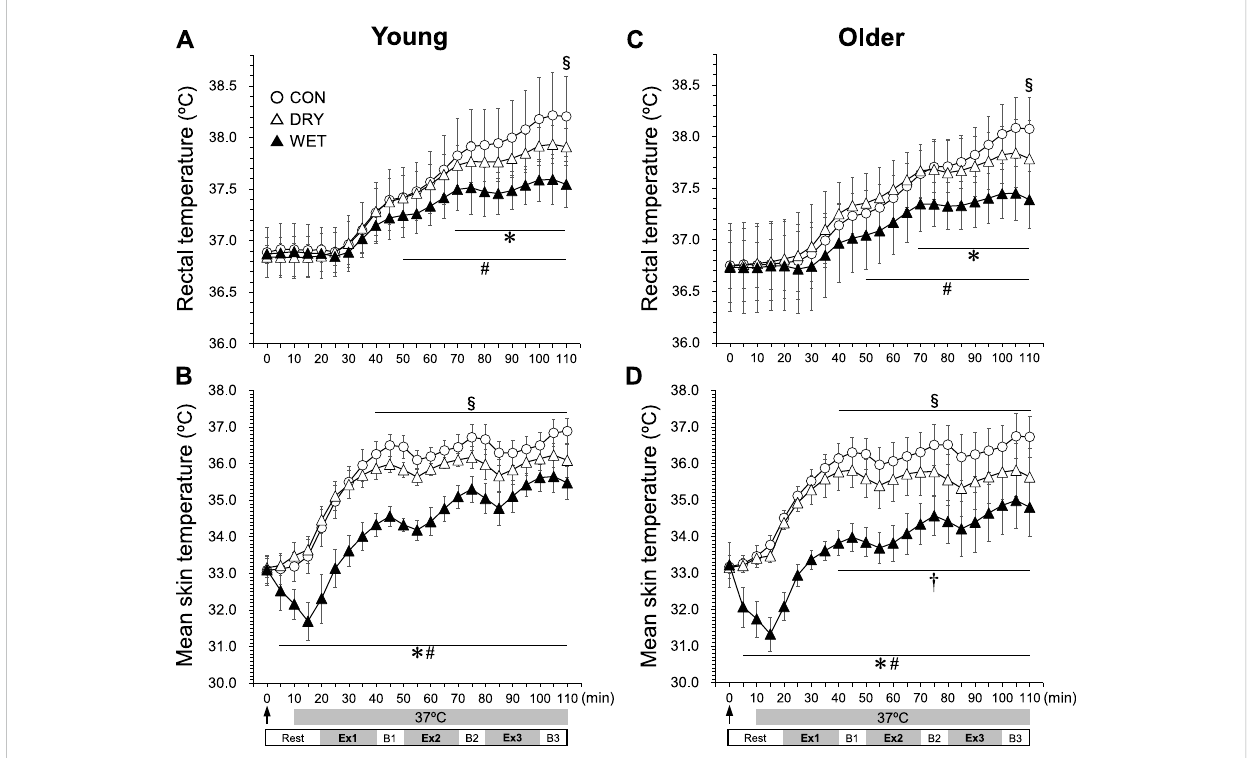
FIGURE 1 Rectal (A,C) and mean skin temperature (B,D) responses during three bouts of intermittent exercise (Ex1 – 3) in hot conditions (37 ° C, 50% RH) interspersed by three breaks (B1 – 3) in the young (left) and older (right) groups whilewearing a dry inner t-shirt without ventilationgarment fanning in the control (CON, open circles), a dry inner t-shirt with ventilation garment fanning (DRY, opened triangles), and a wetted inner t-shirt with ventilation garments fanning (WET, closed triangles). The arrow indicates the start of fanning (DRY) and wetting and fanning (WET). *Signi fi cantly different for CON vs. WET trial, p < 0.05. #Signi fi cantly different for DRY vs. WET trial, p < 0.05. §Signi fi cantly different for CON vs. DRY trial, p < 0.05. † Signi fi cantly different for young vs. older in the WET trial, p < 0.05. Data are expressed as the mean ± SD for eight